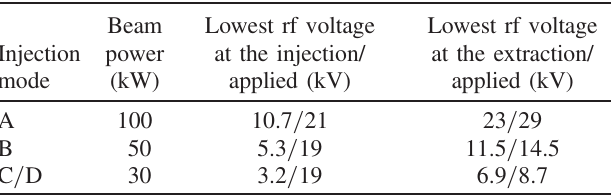
TABLE II. Radio frequency voltage lower limits by the beam loading effect and the applied values for different beam